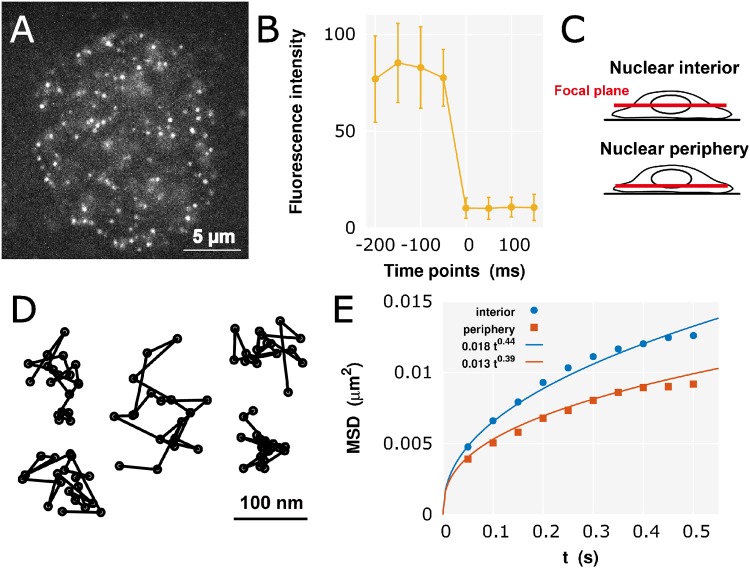
Single-nucleosome imaging and analysis.(A) Single-nucleosome image of a human HeLa cell nucleus expressing H2B-PA-mCherry. Each dot represents single nucleosome. (B) Evidence that each dot represents single-nucleosome molecule. Each H2B-PA-mCherry dot shows single-step photobleaching. The vertical axis represents the fluorescence intensity of each H2B-PA-mCherry dot. The horizontal axis is the tracking time series (each photobleaching point is set as time 0; the average and the standard deviation at each time point were calculated for 50 dots.). Due to the clear single-step photobleaching profile of the H2B-PA-mCherry dots, each dot shows a single H2B-PA-mCherry molecule in a single nucleosome. (C) A scheme for nuclear interior (Top) and periphery (Bottom) imaging. Focal plane (red) in the living cells is shown. See also S1 Fig. (D) Representative trajectories of fluorescently labeled single nucleosome (50 ms per frame). (E) Plots of the MSD at the interior and periphery regions. These fit well with the MSD curves using Eq 1.